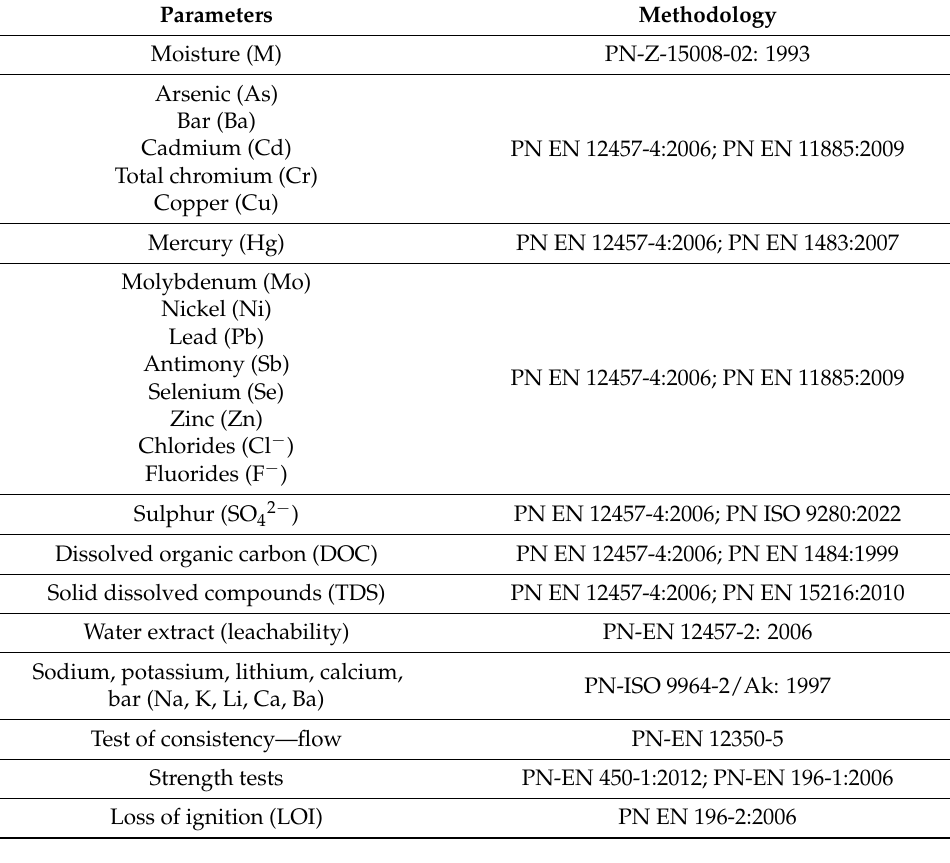
Table 3. Parameters and methodology of MSWIBA and geopolymer research.